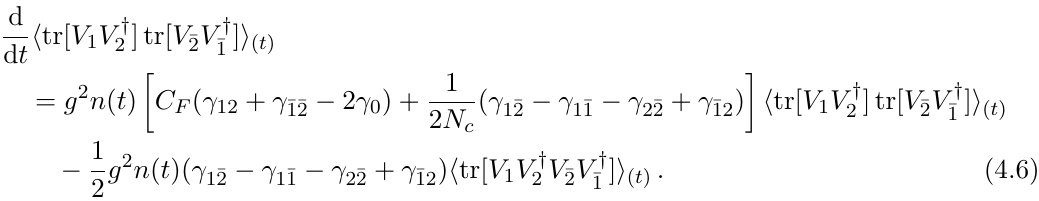
† † tr[ V ] tr[ V ] i , both going from times t 1¯2 ≡ h ¯2 V 1 V ¯1 2